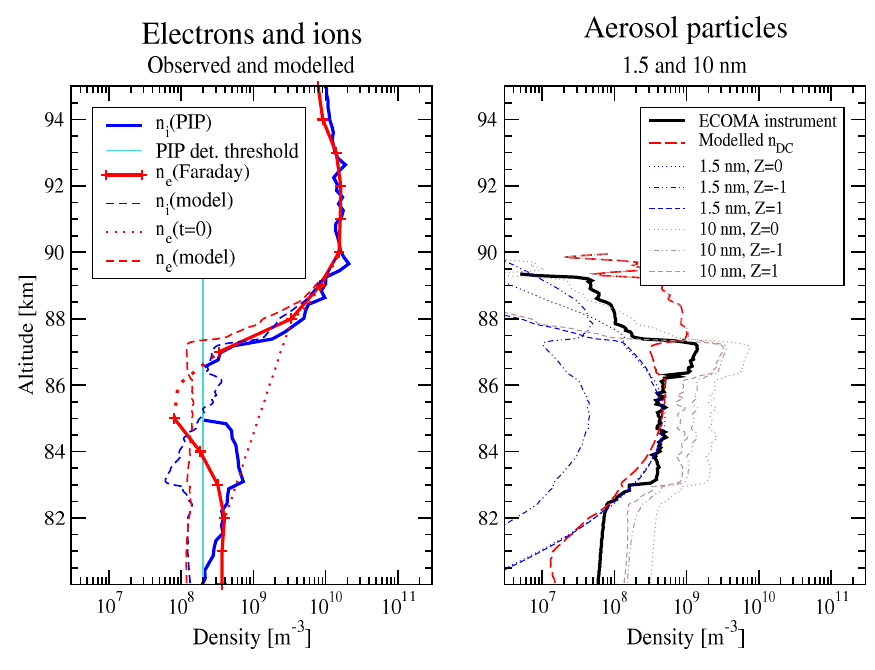
Fig. 7. Model with the same r a = 1 . 5nm smoke distribution as in Fig. 6, and in addition r a = 10nm particles with 10 times the density measured by the ECOMA instrument (assuming all particles have Z =− 1). A recombination coefficient α = α m is used, and I a = 10 − 2 s − 1 and 3 × 10 − 2 s − 1 for the 1.5 and 10nm particles,